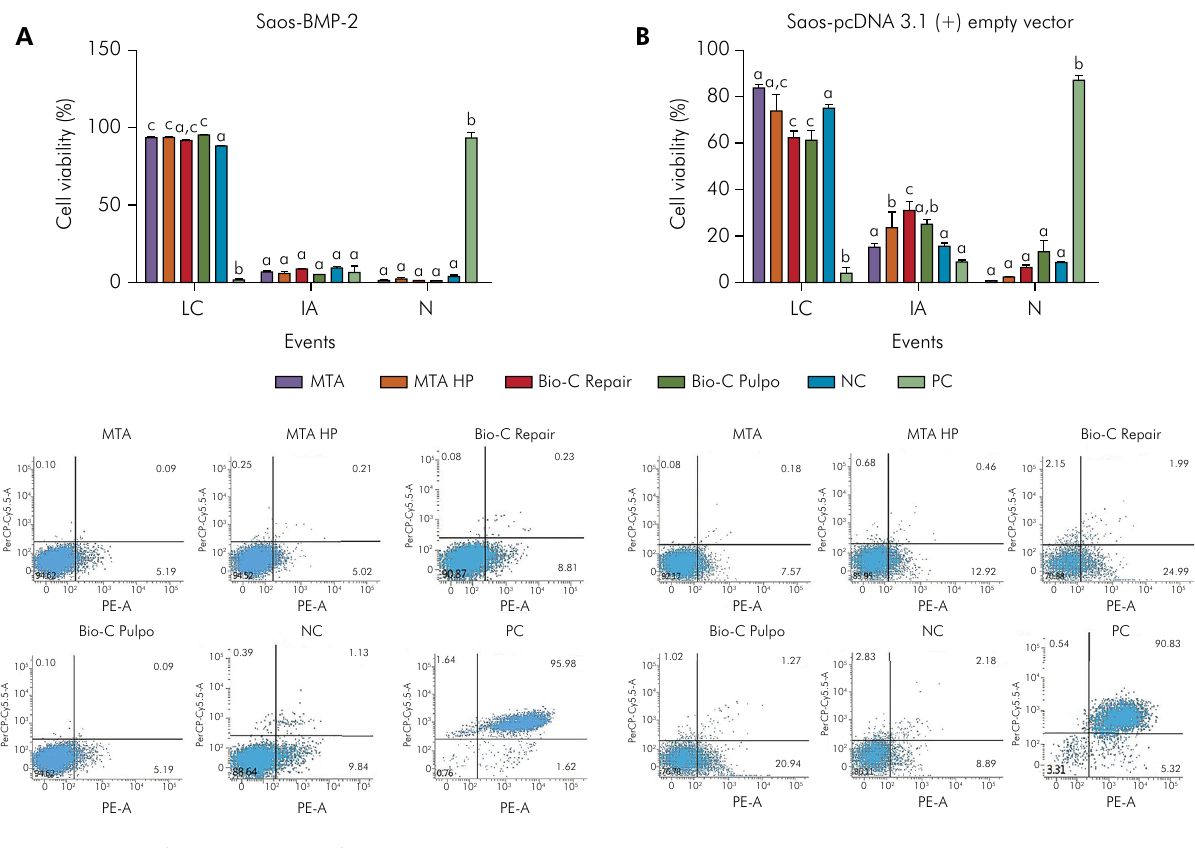
Figure 2. Flow cytometry assay. (a) Viability and mortality by apoptosis or necrosis of Saos-2 osteoblastic-transfected cells (Saos- BMP-2) and (b) Saos-pcDNA 3.1 (+) empty vector after exposure to cement extracts at 1:12 dilution for 24 hours. Cells exposed to serum-free culture medium were the negative control, while cells treated with hydrogen peroxide (1 mM) were the positive control group. (b) Representative 2-dimensional flow cytometry dot plot of data derived from PE-AnV and 7 AAD stained Saos-2 osteoblastic-transfected cells of the control and the cement extract groups. Bars with different letters represent significant differences among groups in each population analyzed. The population of living cells (LC) (annexin-/ PI-), initial apoptosis (IA) (annexin+/ PI-), late apoptosis and/or necrotic (N) cells (annexin+/ PI+, and annexin-/ PI+) are represented at the bottom left, bottom right, top right and top left quadrants,